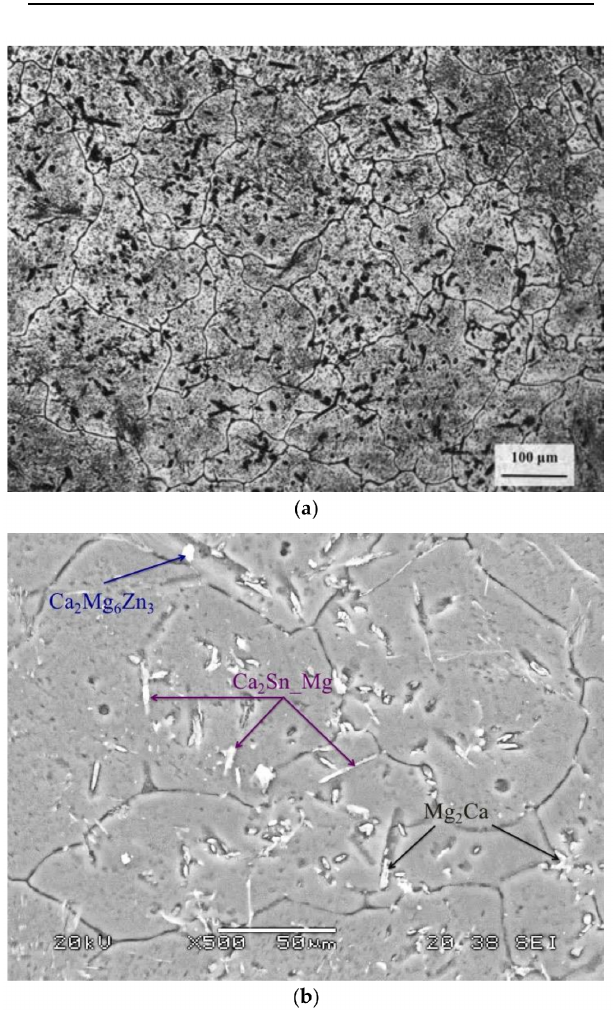
Figure 1. ( a ) Optical microstructure and ( b ) SEM micrograph of as-cast TX32-0.4Al-0.4Zn (TXAZ3200)